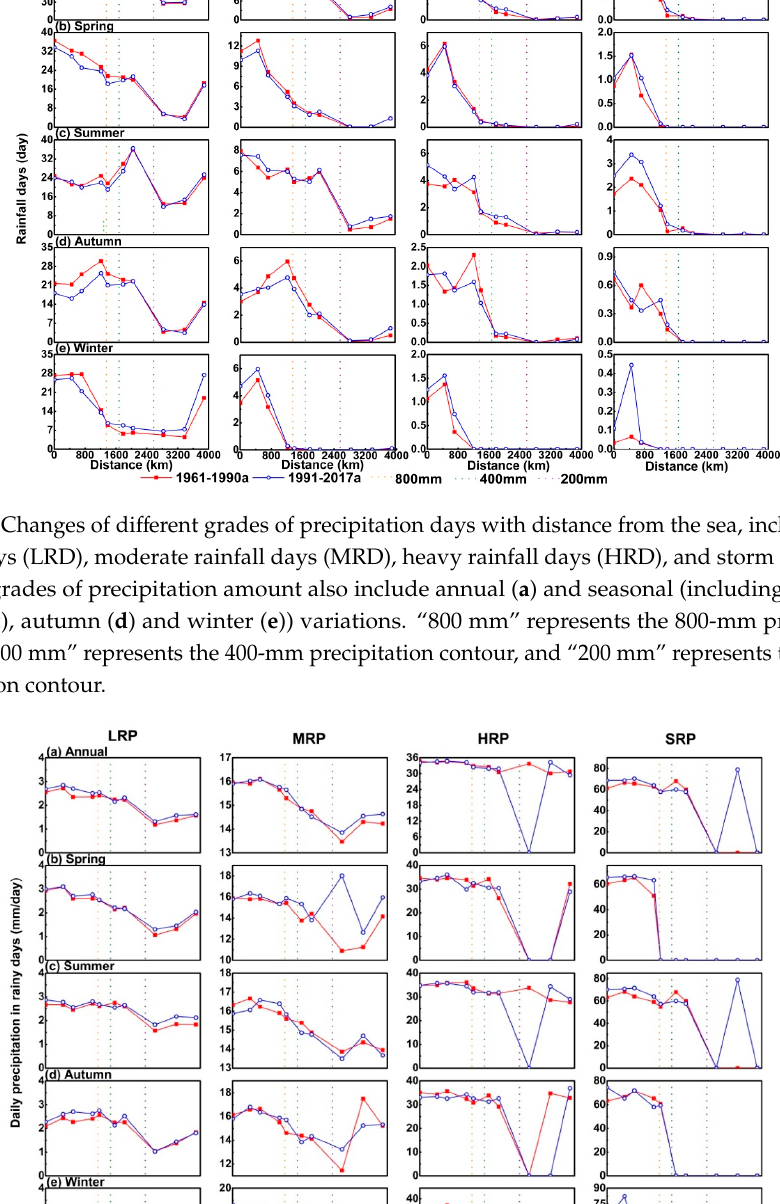
Figure 12. Changes of daily precipitation of different rainy day grades with distance from the sea, including daily precipitation on light rainfall days (LRP), daily precipitation on moderate rainfall days (MRP), daily precipitation on heavy rainfall days (HRP), and daily precipitation on stormy days (SRP). Different grades of precipitation amount also include annual ( a ) and seasonal (including spring ( b ), summer ( c ), autumn ( d ) and winter ( e )) variations. “800 mm” represents the 800-mm precipitation contour, “400 mm” represents the 400-mm precipitation contour, and “200 mm” represents the 200-mm precipitation contour.